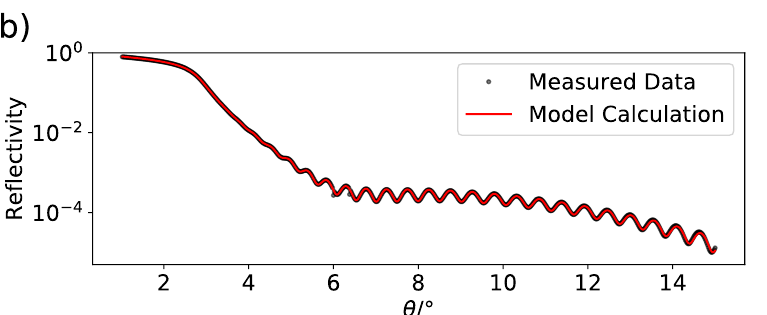
Figure 2. ( a ) The posterior distributions for relevant parameters δ Si h obtained from the MCMC sampling. The red line marks the mean of the distribution and the dotted black lines in the histogram indicates a 3 σ interval. In the top right corner, a sketch of the used layer stack is shown. ( b ) Comparison of the experimental data (black stars) and the model calculation (red line) as obtained by the